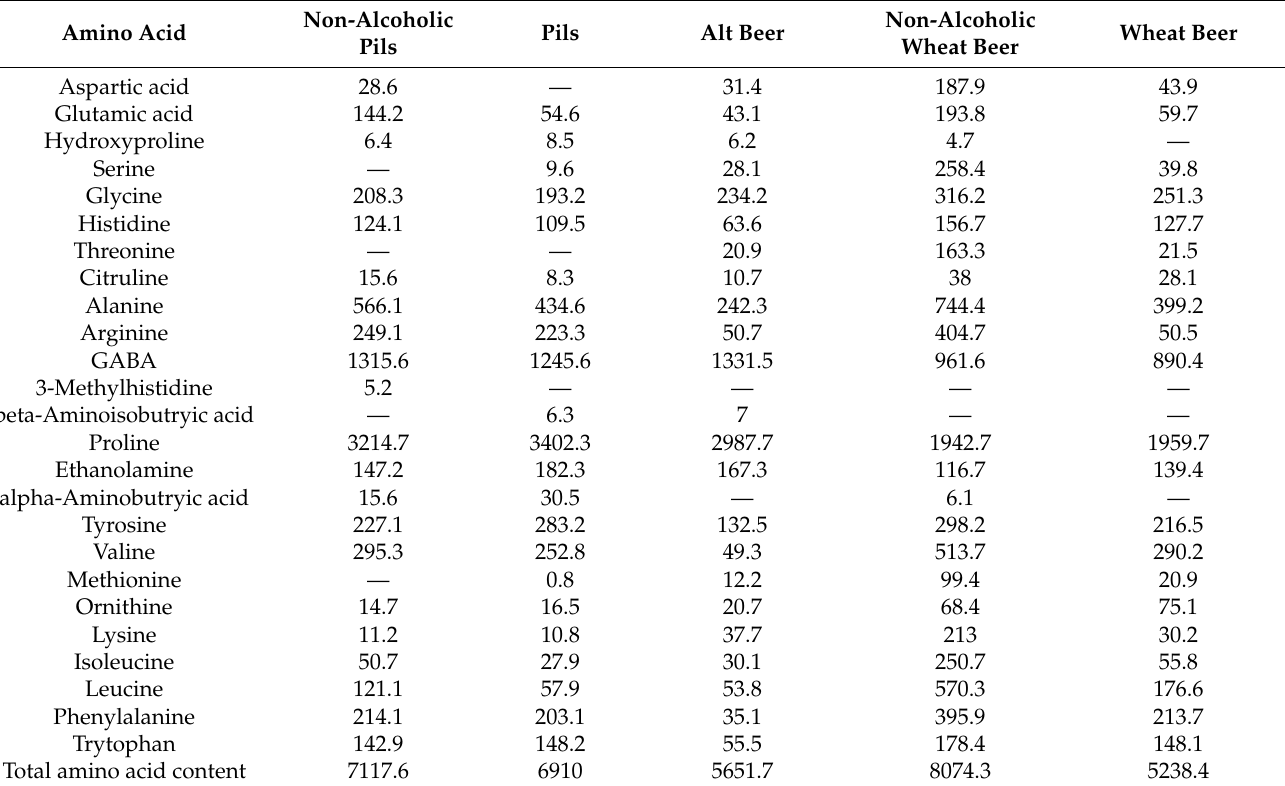
Table 8. Results of the determination of amino acids in beer samples (umol/L) [41].